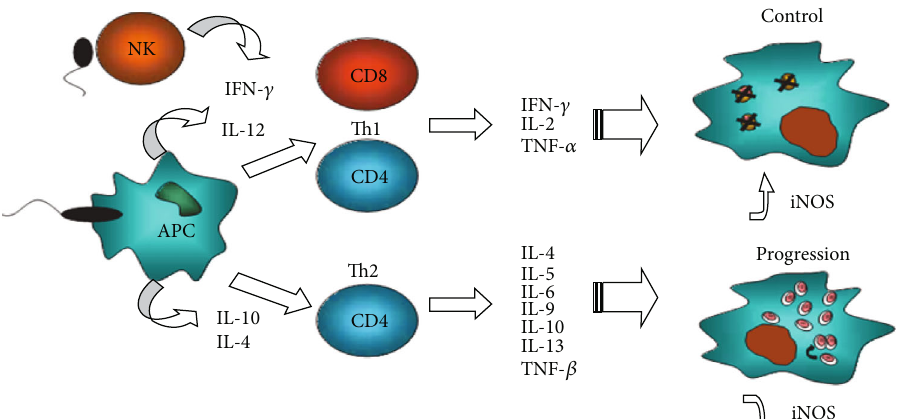
Figure 3: CD4 + Th1vTh2 cell response towards Leishmania infection (source: https://www.google.com; J. H. Ruiz & I. Becker (2007): CD8 cytotoxic T cells in cutaneous